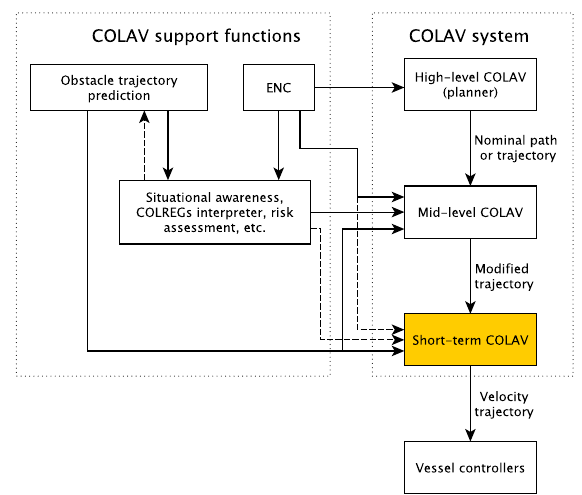
Figure 1: A hybrid architecture with three layers. The sup- port functions provide relevant information for the COLAV algorithms, including prediction of ob- stacle trajectories, static obstacles from electronic nautical charts (ENC) and situational awareness in the form of COLREGs situations. Courtesy of (Eriksen et al.,